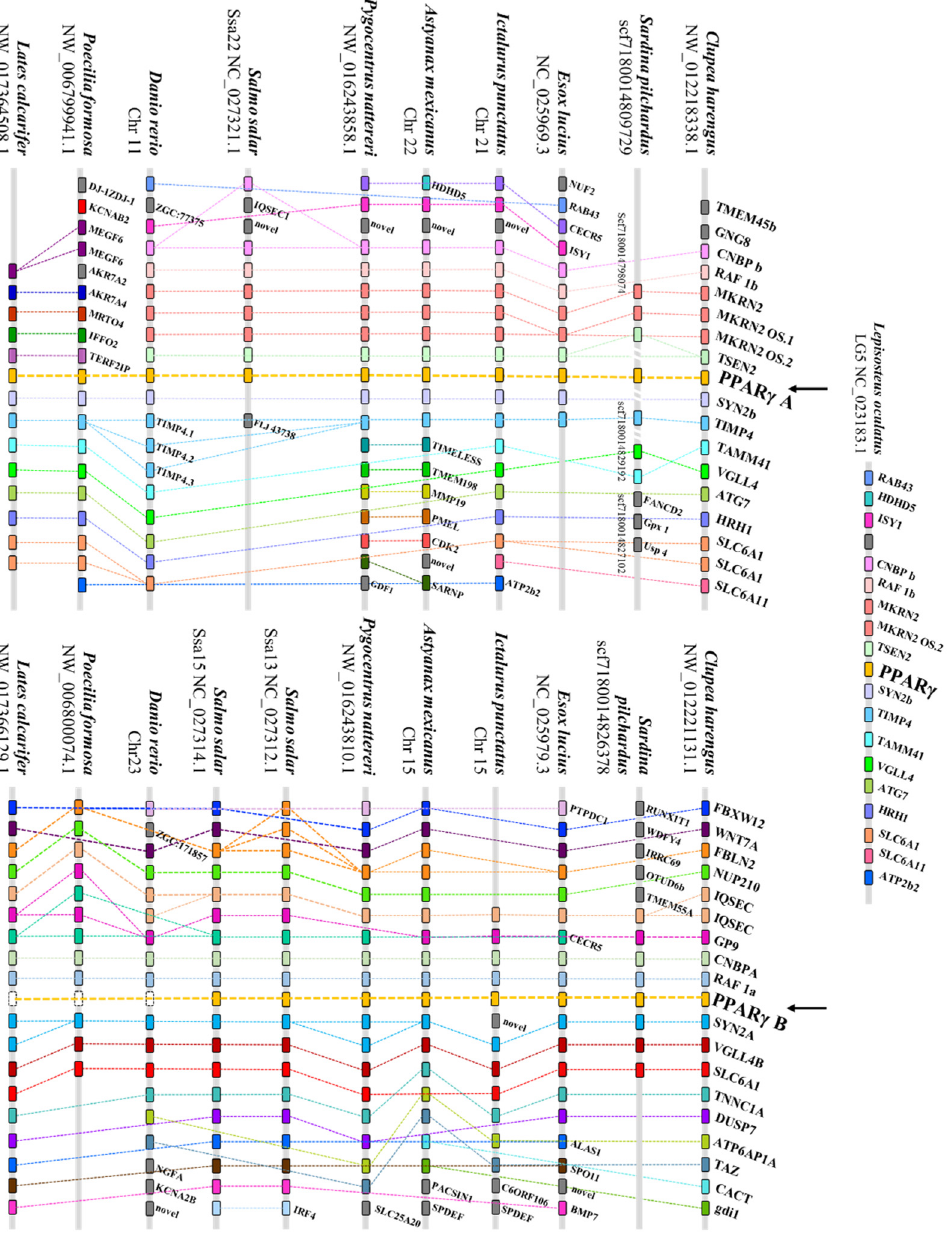
Figure 2. Synteny maps of PPAR γ A and PPAR γ B loci in representative ray-finned fish species, namely the teleosts Atlantic herring ( Clupea harengus ), common European sardine ( Sardina pilchardus ), northern pike ( Esox lucius ), channel catfish ( Ictalurus punctatus ), Mexican tetra ( Astyanax mexicanus ), red-bellied piranha ( Pygocentrus nattereri ), Atlantic salmon ( Salmo salar ), zebrafish ( Danio rerio ), Amazon molly ( Poecilia formosa ) and barramundi perch ( Lates calcarifer ). Beyond these, the synteny map of the nonteleost spotted gar ( Lepisosteus oculatus ) PPAR γ loci is also presented. Legend: white box with dashed limit means that gene was lost.